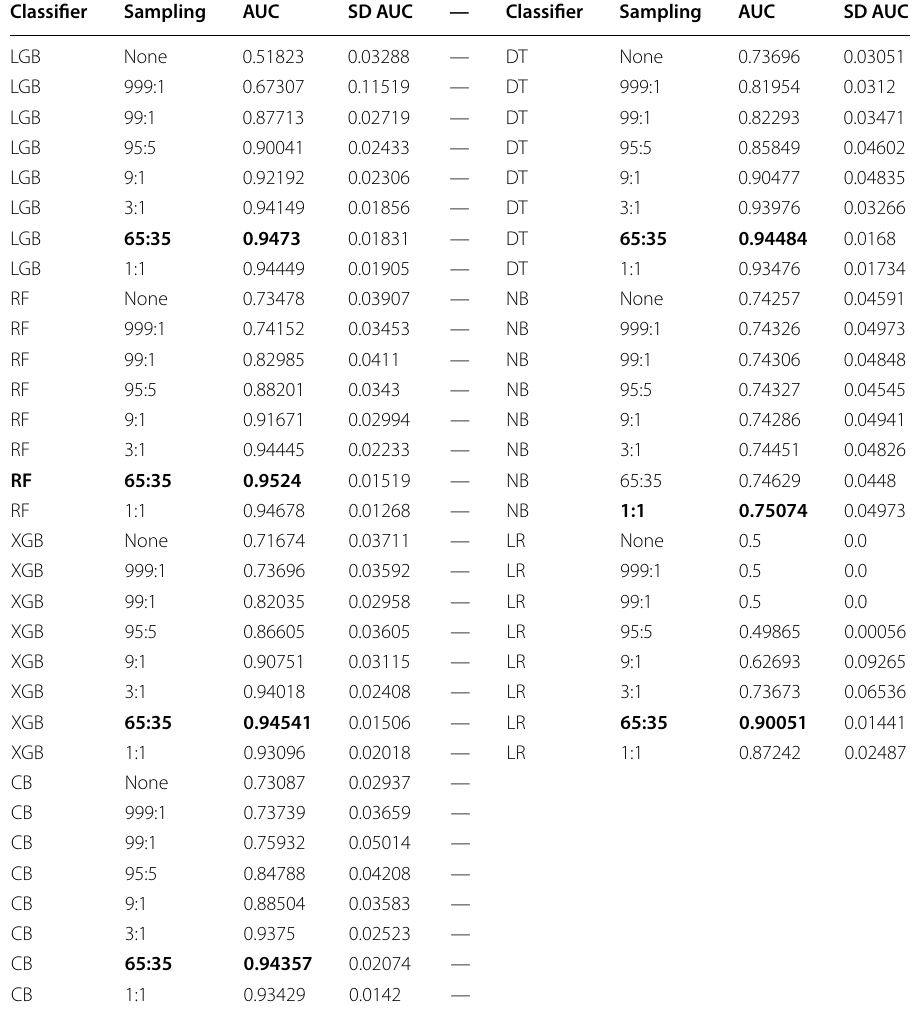
Bolded values indicate highest